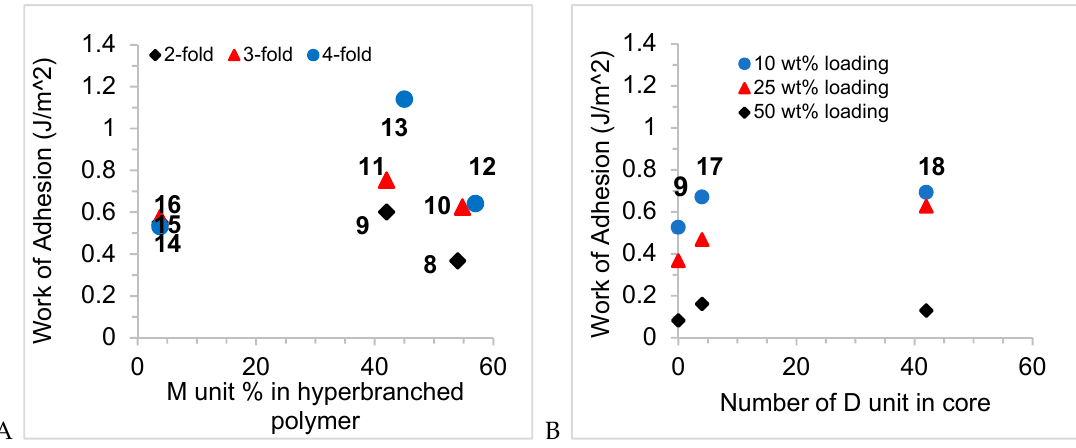
Figure 7. ( A ) Adhesion work to gels (25 wt% loading) as a function of M unit mol% on the Figure7. ( A )Adhesionworktogels(25wt%loading)asafunctionofMunitmol%onthehyperbranched hyperbranched oils). ( B ) Adhesion work as a function of different core length in the elastomer. oils). ( B ) Adhesion work as a function of di ff erent core length in the